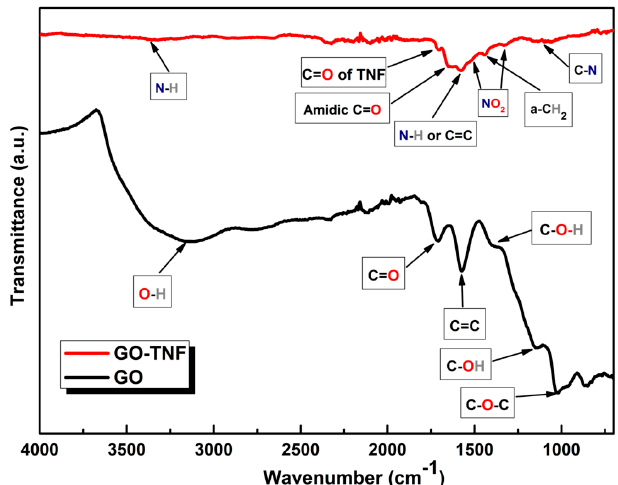
Figure 3. ATR FT-IR spectra of graphene oxide (GO) (black line) and GO-TNF (red line) in transmission mode.